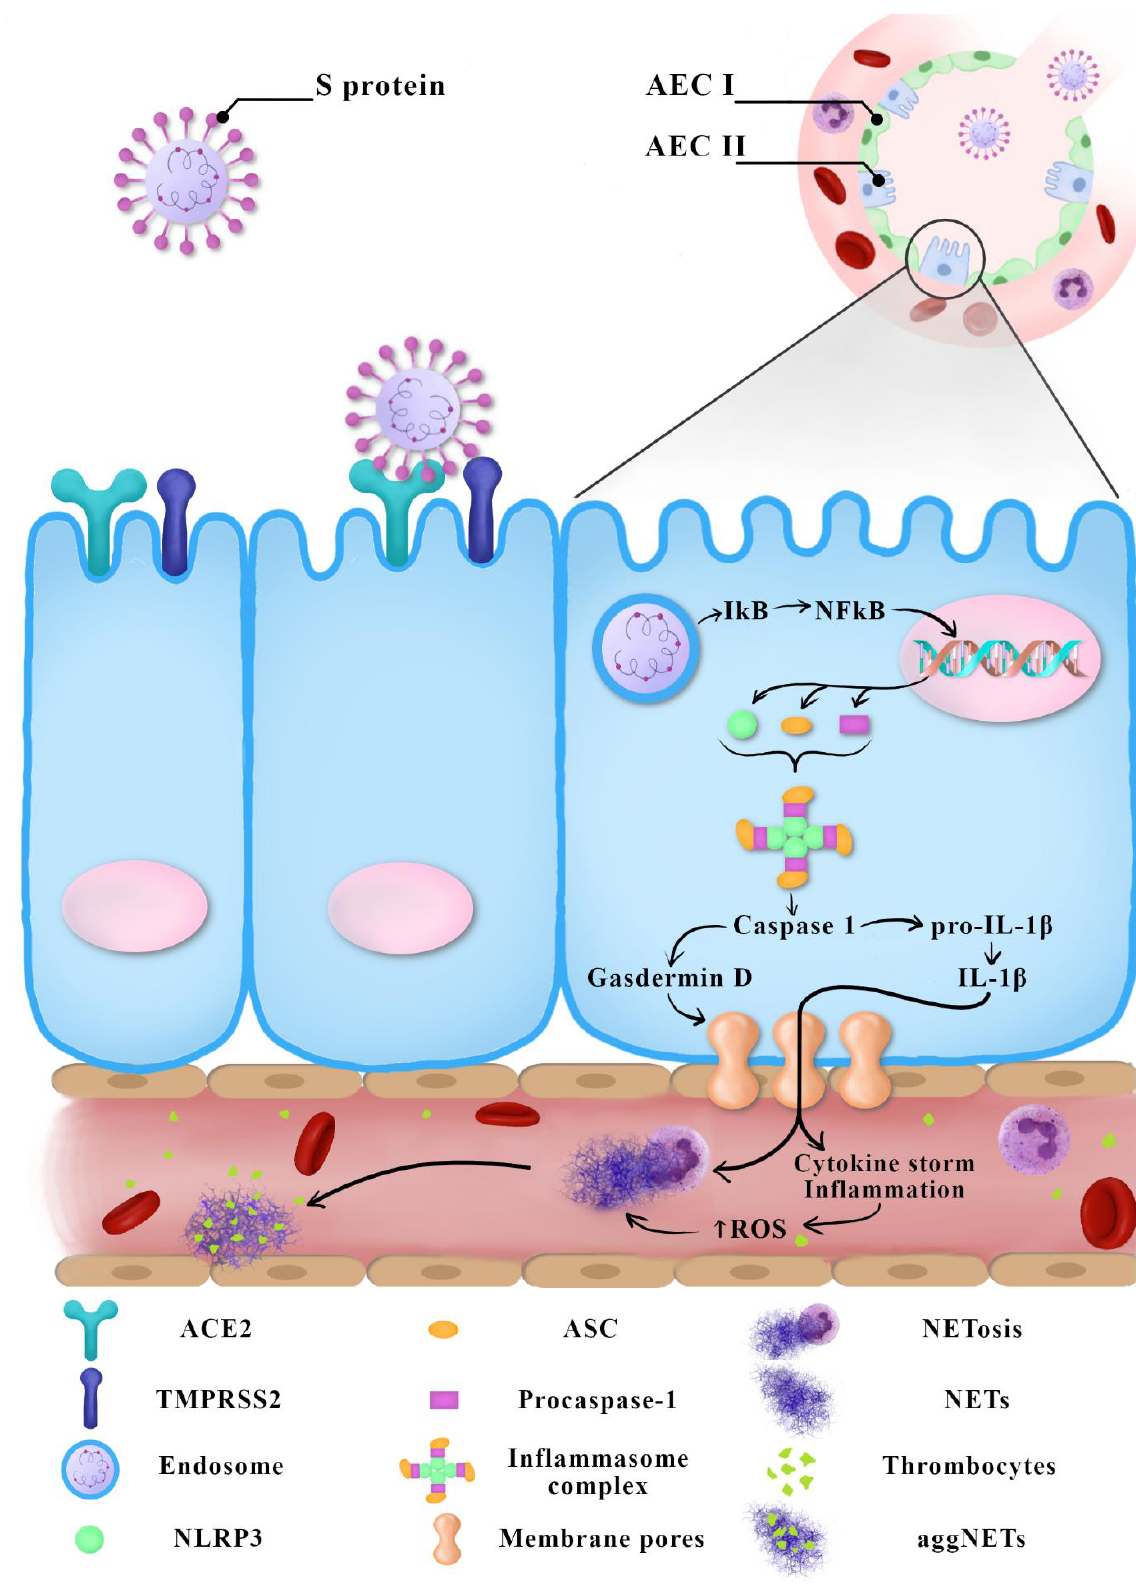
Figure 1. Suggested COVID-19 immunopathogenesis—the latest reports.